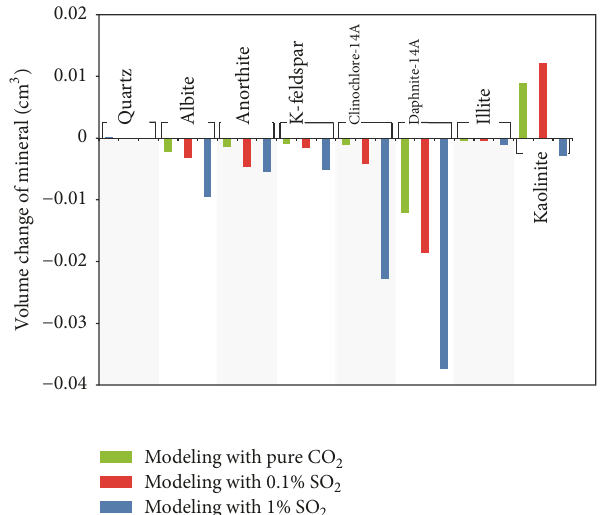
Figure 8: Changes in the volume of primary minerals in the modeling (green bar = pure CO 2 case, red bar = 0.1% SO 2 case, and blue bar = 1% SO 2